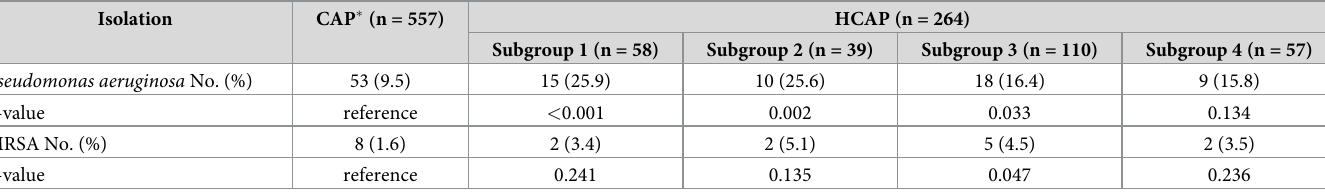
Table 3. Comparison of antibiotic-resistant pathogen distribution between CAP and HCAP subgroups.